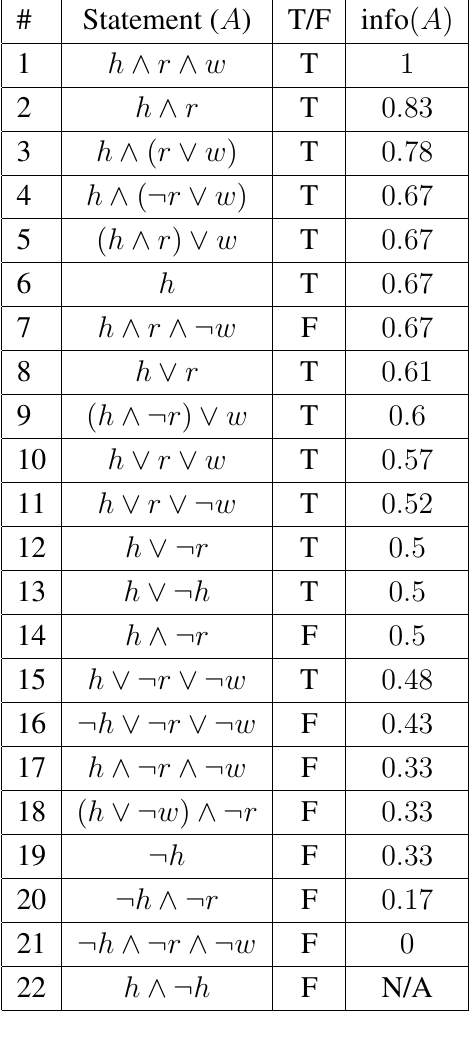
Table 5. Information yield results using Tichy/Oddie